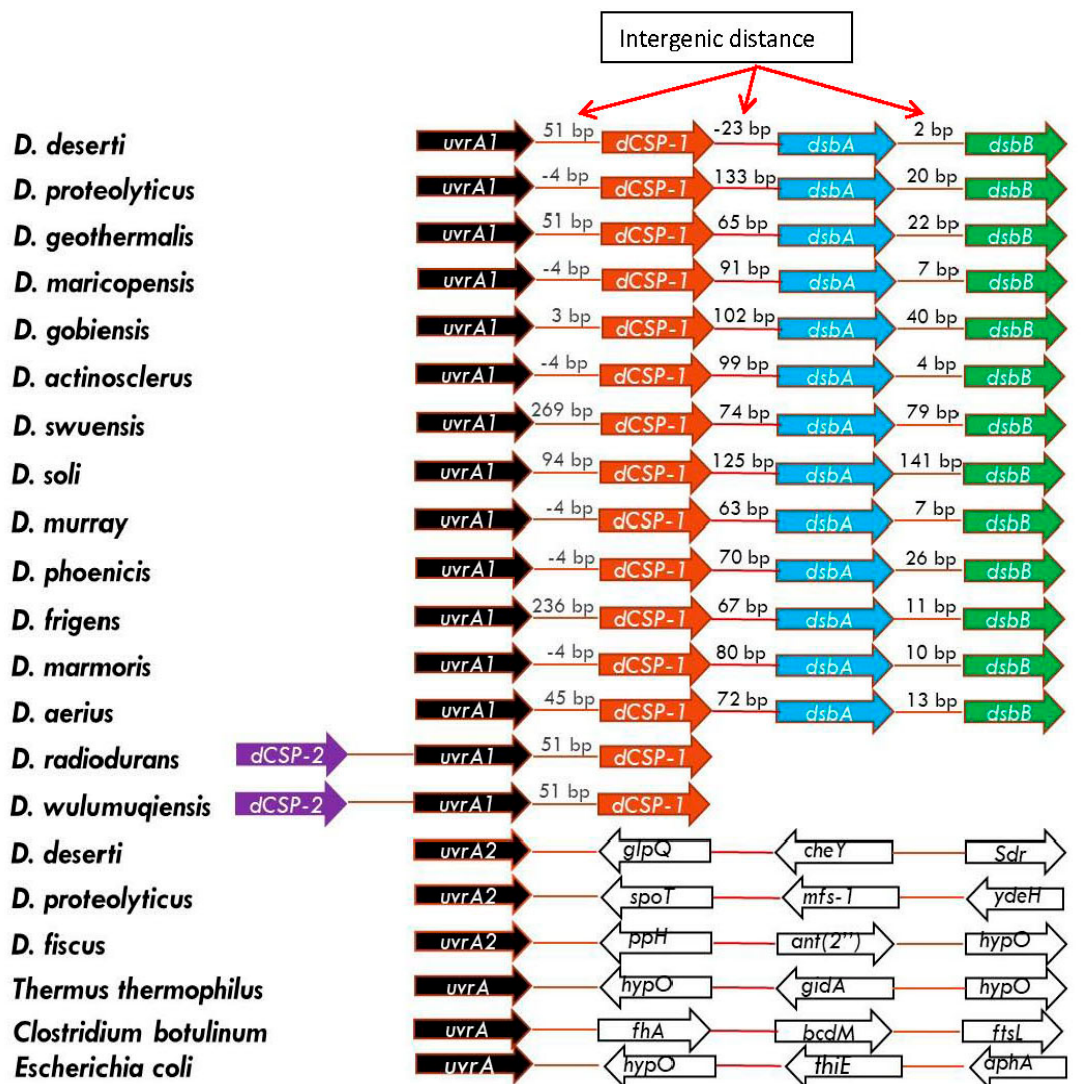
Figure 4. Genomic neighborhood of the gene for UvrA1 protein from Deinococcus species showing its specific linkage to the genes for dCSP-1, DsbA and DsbB proteins. The genes for these four proteins are oriented in the same direction and their intergenic distances in most cases are <100 base pairs indicating that they likely form an operon. The genes for UvrA2 from Deinococcus as well as the uvrA genes from other bacterial groups do not show specific genetic linkage to genes for any of these proteins. In D. radiodurans and D. wulumuqiensis , the gene for UvrA1 shows specific genetic linkage to the genes for dCSP-2 and dCSP-1 proteins, both of which are Deinococcus -specific.